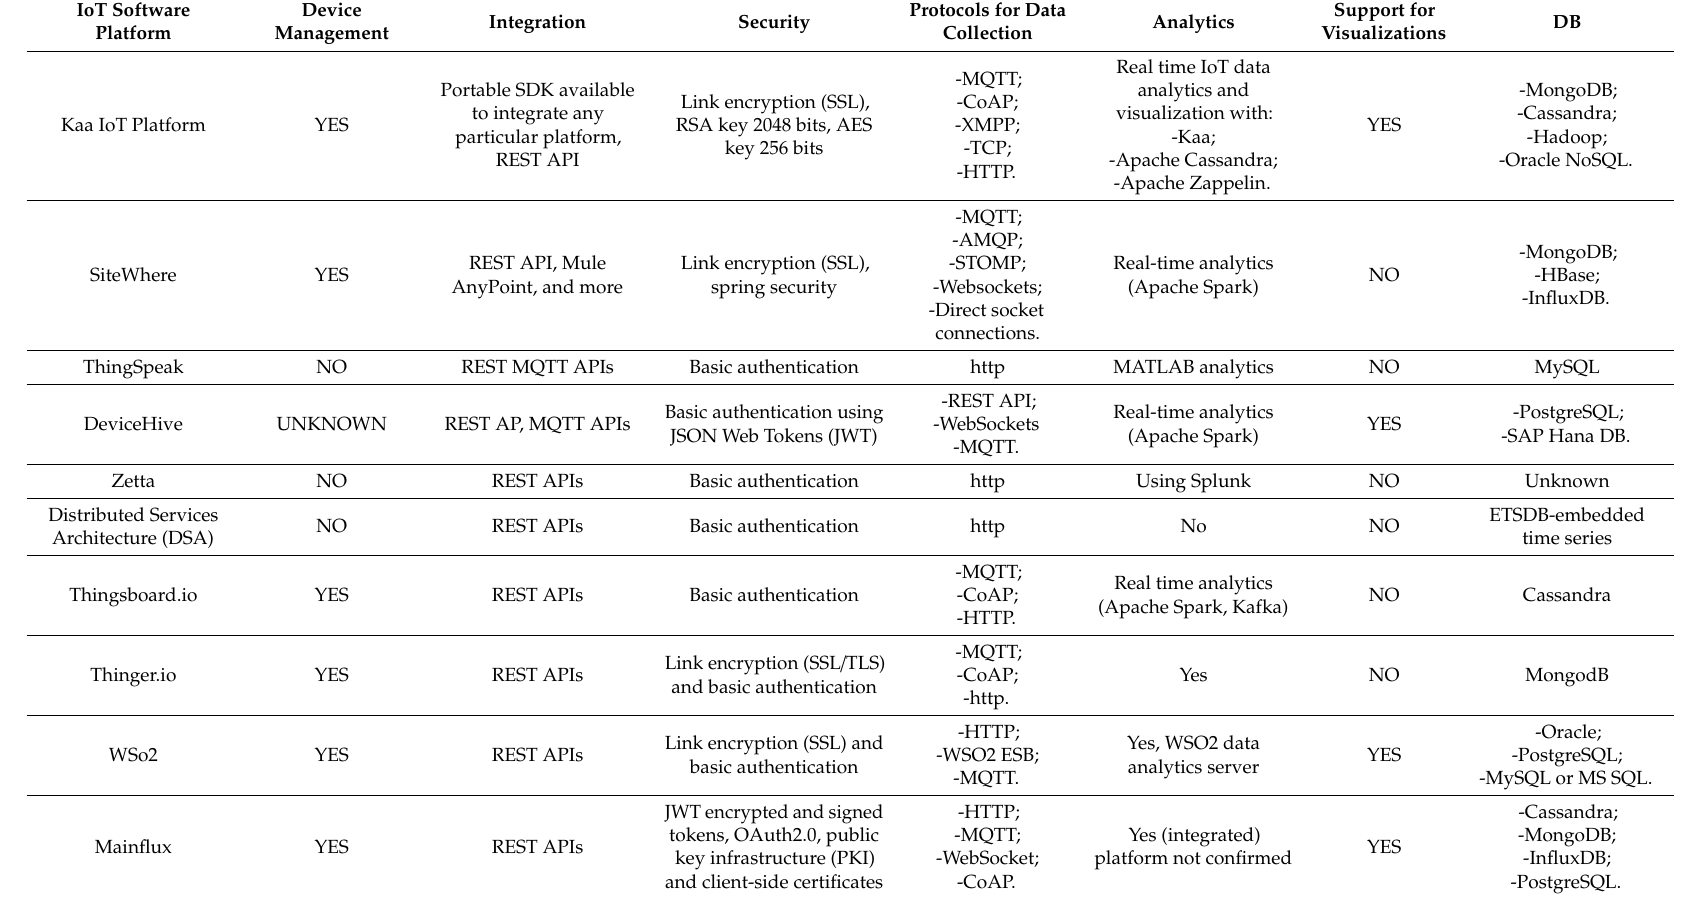
Table 1. Scheme of the principal open IoT platforms and relative